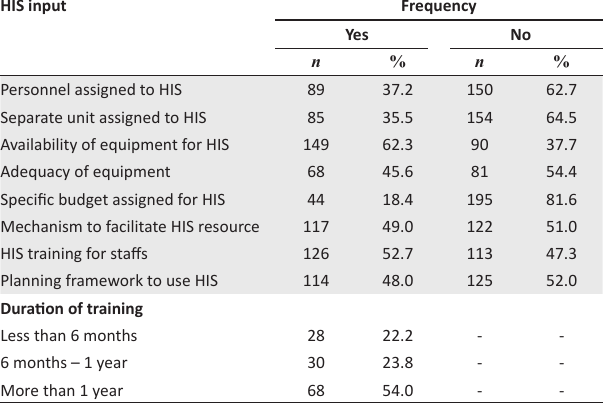
TABLE 2: Health facility department’s HIS inputs in Dire Dawa Administration, April 2013.